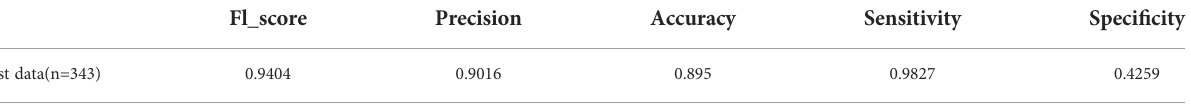
TABLE 5 Confusion matrix metrics oftest data.